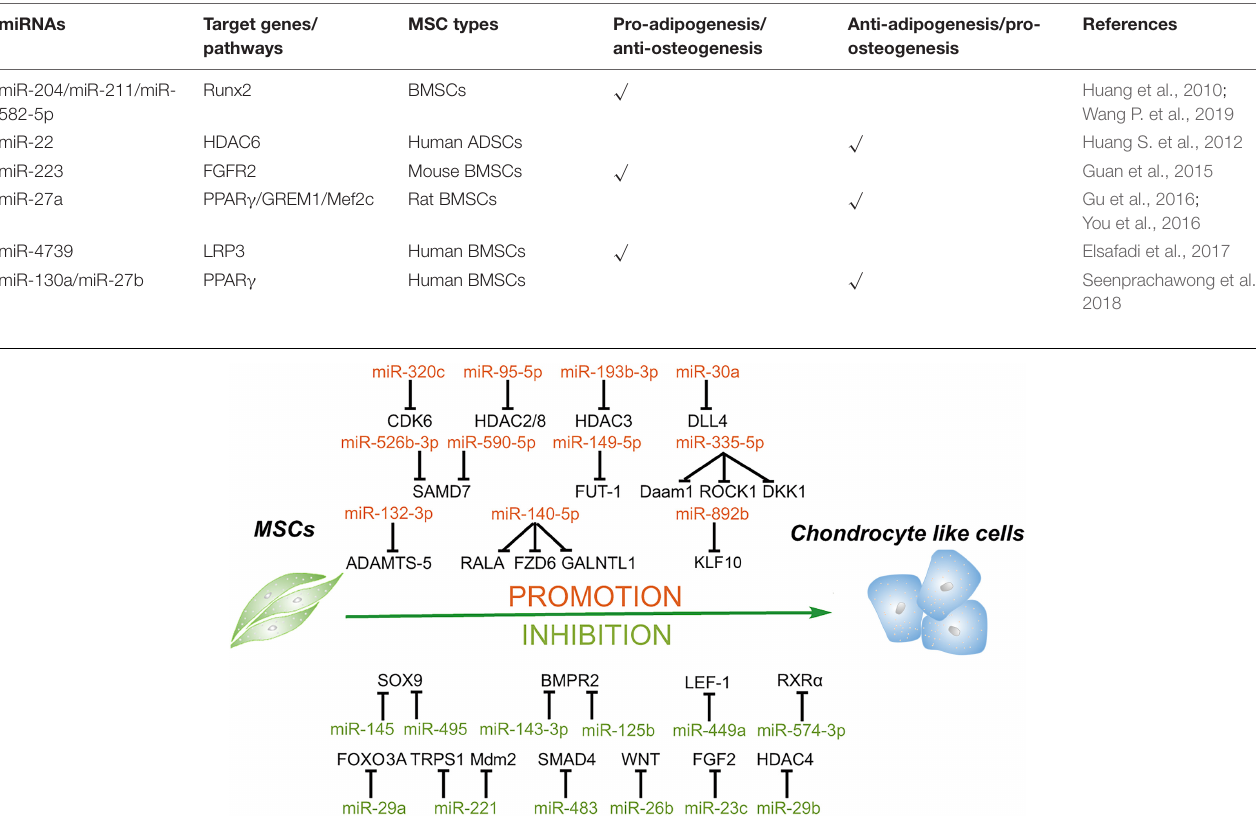
FIGURE 4 | Roles of miRNAs in chondrogenic differentiation of mesenchymal stem cells. MiRNAs enhance the chondrogenesis of MSCs via downregulating the expression of the negative regulators of chondrogenesis, activators of Notch and NF- κ B signaling, enhancer of chondrocyte hypertrophy, including RALA, FZD6, GALNTL1, DLL4, HDAC4, SMAD7, KLF10, etc. In addition, some miRNAs suppress this process through targeting key factors of chondrogenesis, including SOX9, BMPR2, FOXO3A, HDAC4, SMAD4, and so